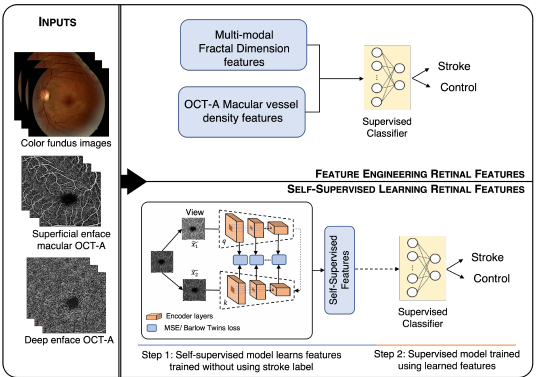
Figure 1. Workflow of the proposed method for stroke detection. The workflow shows two methods; the first is feature engineering (above), and the second is self-supervised learning (below). The color fundus, superficial, and deep enface OCT-A images are used as an input for both approaches. The features obtained from feature engineering and self-supervised learning are finally given to the supervised classifiers for stroke vs. control